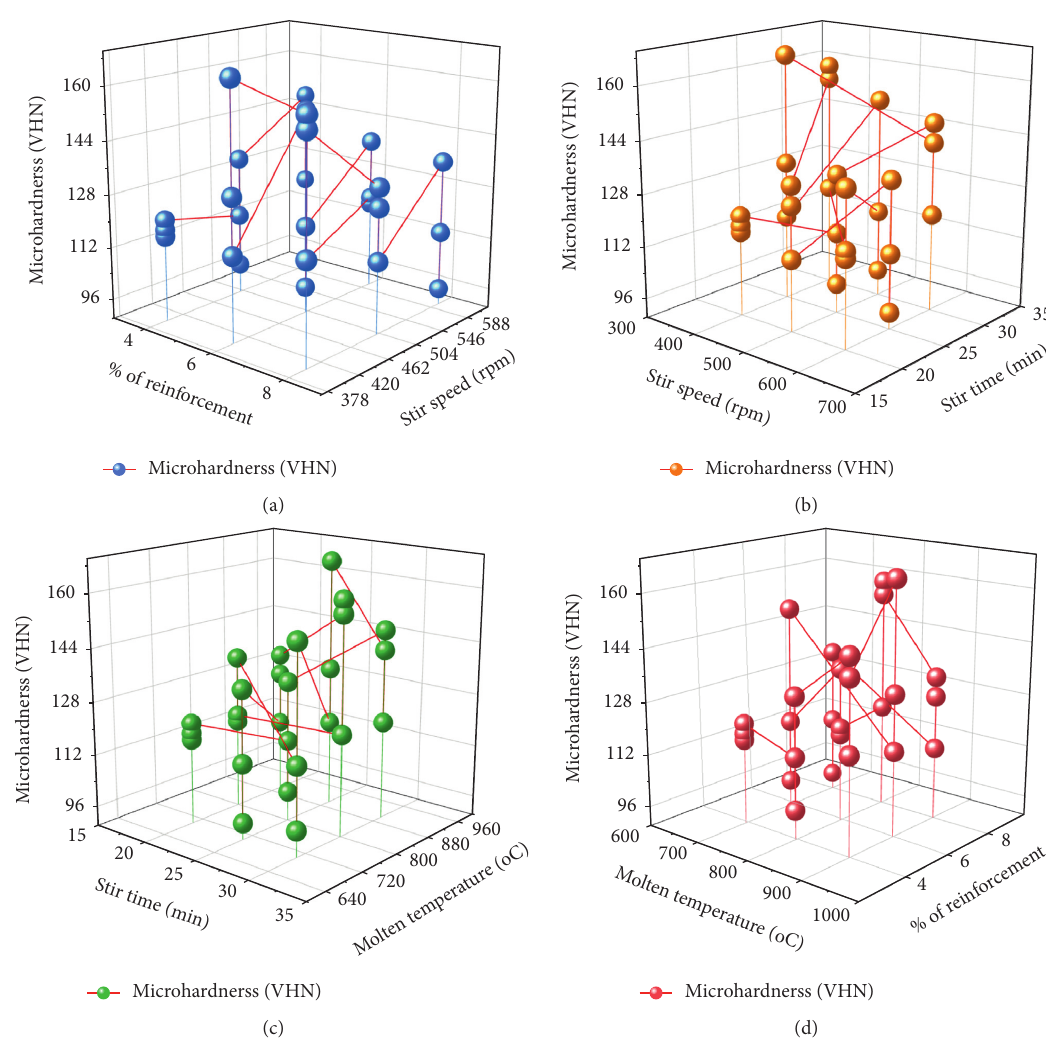
Figure 8: 3D Trajectory plot for microhardness: (a) % of reinforcement vs stir speed; (b) stir speed vs stir time; (c) stir time vs molten temperature; (d) molten temperature vs % of reinforcement.